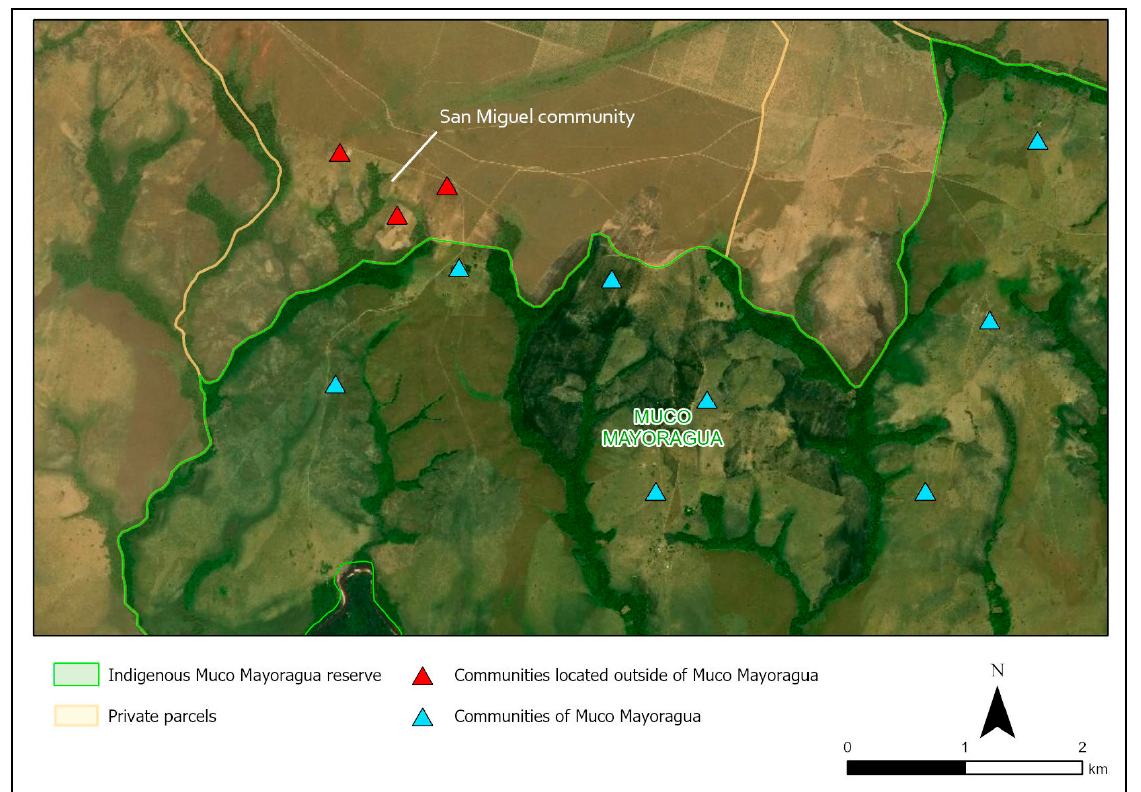
Figure 7. The Indigenous Muco Mayoragua reserve. Three communities (in red) are located outside of the official limits of the reserve but claim to be part of the reserve. Cumaribo, 2020. Source: Land in Peace Project, Kadaster.